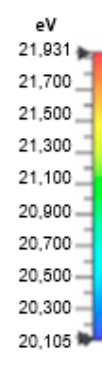
Figure 13. Electrons bunching effect at the end of the circuit.